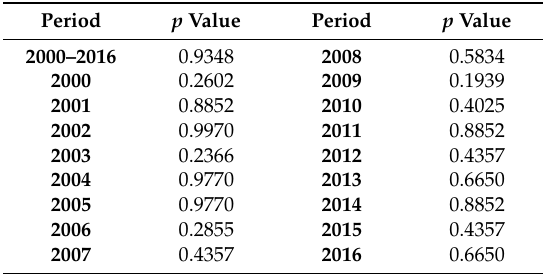
Table 14. Wilcoxon Test results ( p values)—CF indexes.